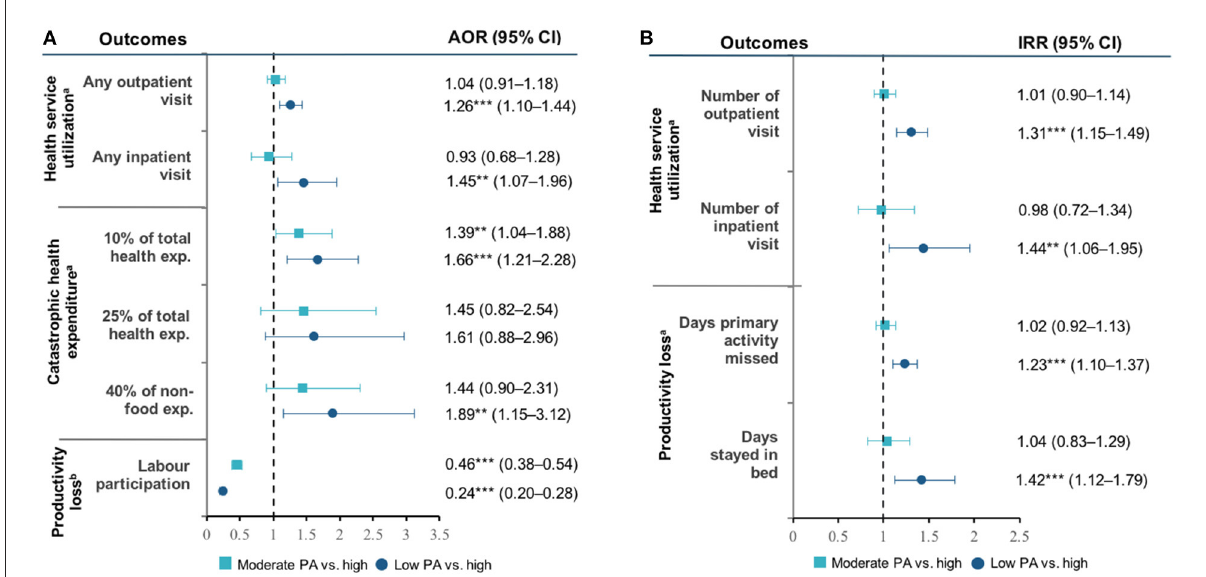
FIGURE2 (A,B) Physical activity and health outcomes. PA, physical activity; CVDs, cardiovascular diseases; AOR, adjusted odds ratio. AOR was estimated using multilevel logistic regression model. a Controlled by sex, age, marital status, ethnicity, education, type of work, residency, region of residency, PCE, insurance coverage, tobacco-use, and food-consumption. b Controlled by marital status, ethnicity, education, type of work, residency, region of residency, PCE, insurance coverage, food-consumption. Significance: ** P < 0.05; *** P <